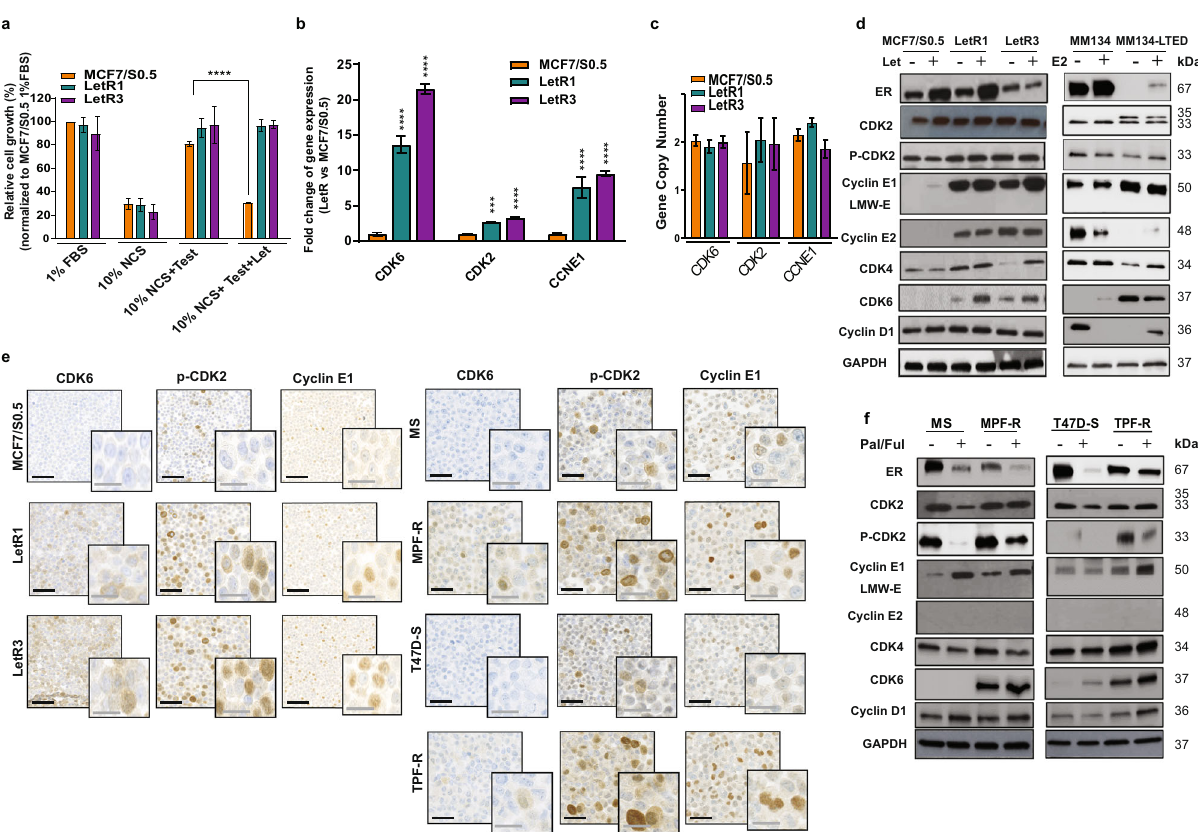
Fig. 1 Altered expression of G1/S transition cooperative cascades cyclin D-CDK4/6-Rb and cyclin E-CDK2-Rb in AI-resistant and combined palbociclib and fulvestrant-resistant ER + BC cells. a Evaluation of cell growth of letrozole-resistant (LetR) cells and the sensitive MCF7/S0.5 cell line by crystal violet colorimetric assay. Relative cell growth (%) of independent experiments in triplicates ± SD is shown. Statistically signi fi cant differences by two-way ANOVA are shown as **** p ≤ 0.0001. b Quantitative RT-PCR verifying the gene expression alteration of CDK6 , CDK2 , and CCNE1 (encodes cyclin E1). The expression was normalized using PUM1 gene and shown as relative expression in LetR vs. MCF7/S0.5 cells. c Quantitative RT-PCR copy-number assay using Taqman copy-number variants (CNV) primers. Average calculated copy- number values are plotted with bars representing values from replicate measurements ( n = 4) ± SD. d Western blotting analysis of lysates from LetR and MCF7/S0.5 cells cultured at aromatase-dependent growth condition (10% NCS + 100 nM testosterone) in the presence or absence